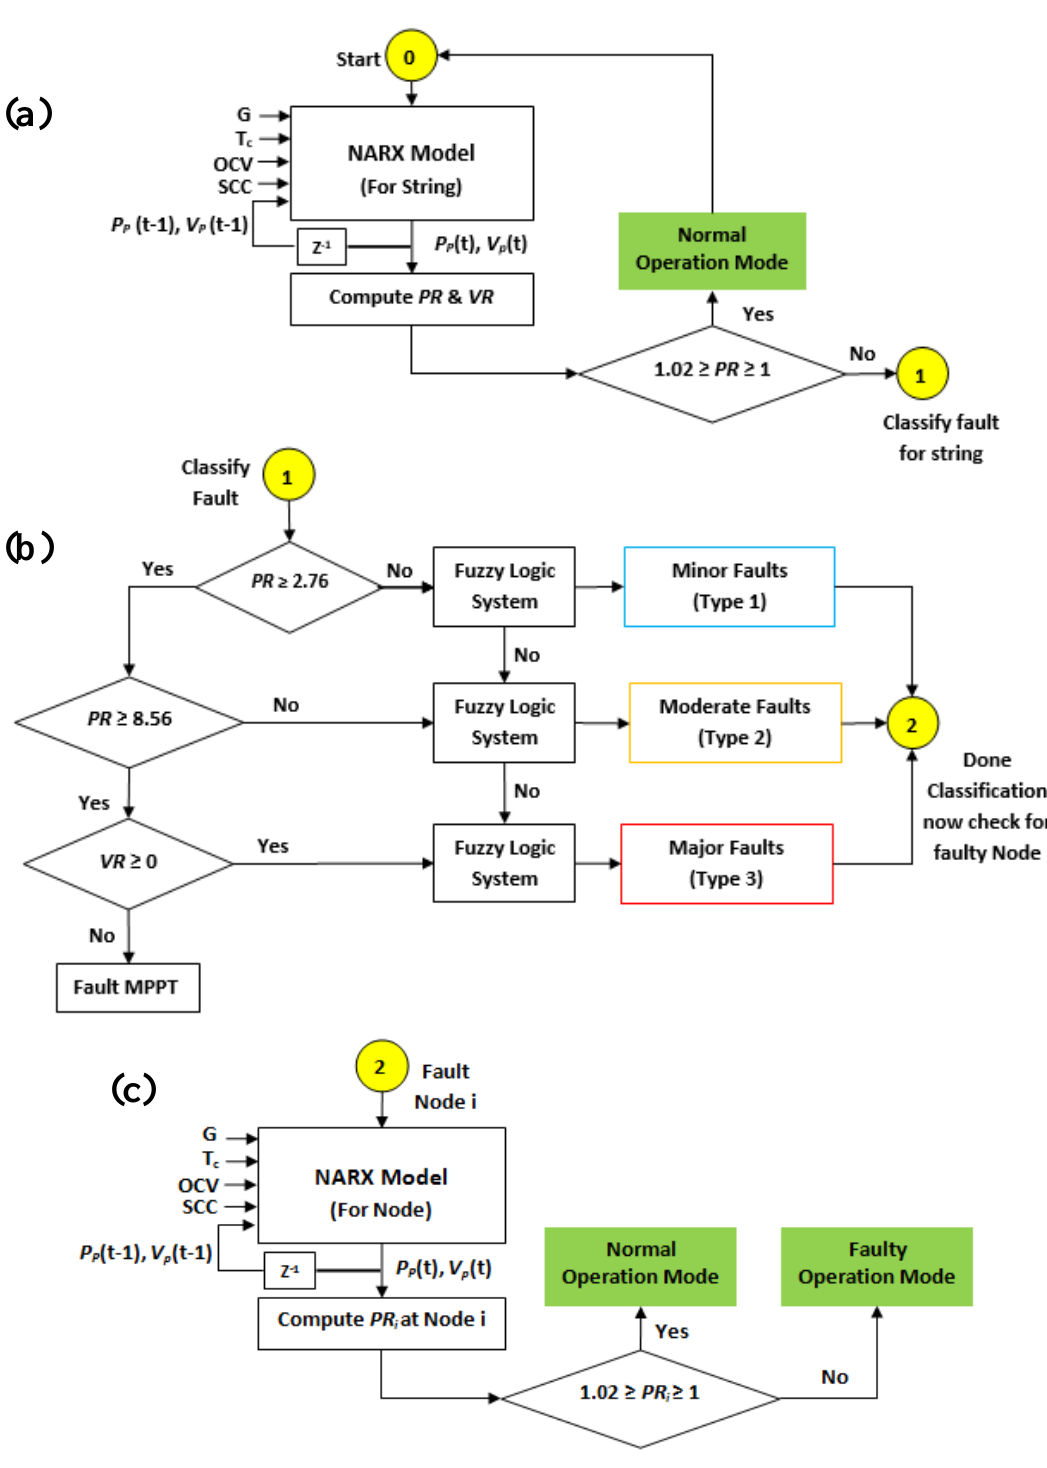
Figure 7. The proposed fault detection algorithm: ( a ) stage 1, ( b ) stage 2, ( c ) stage 3.